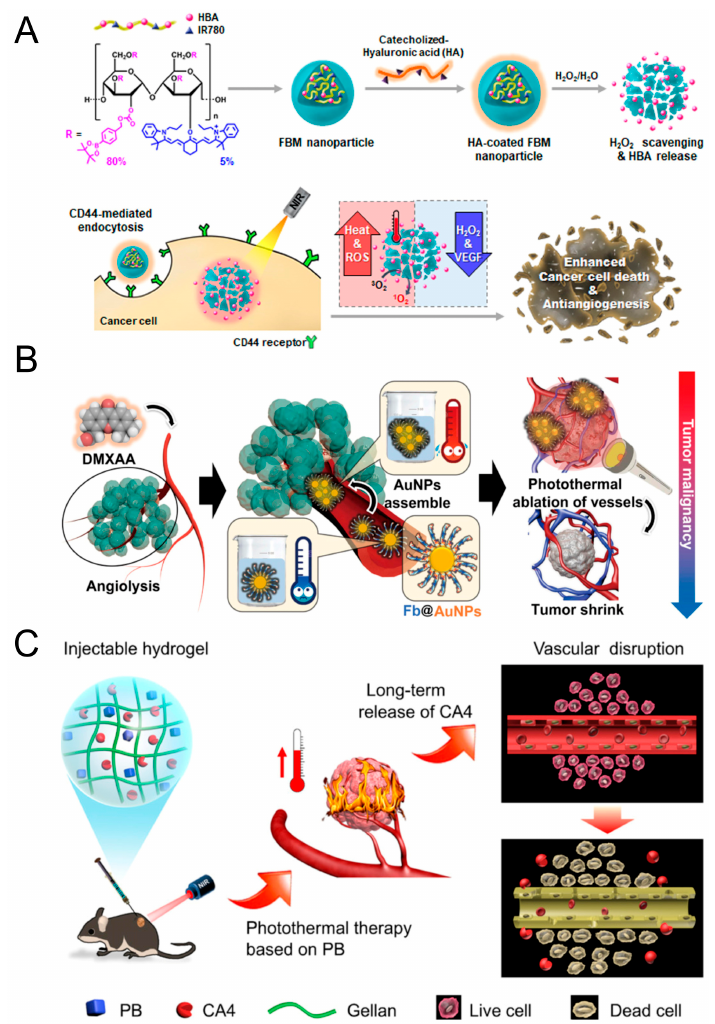
Figure 4. Antivascular treatment enhances the photothermal conversion efficiency of PTT. ( A ) Schematic diagram of HA-FBM nanoparticles as phototherapeutic agents. Adapted with permission